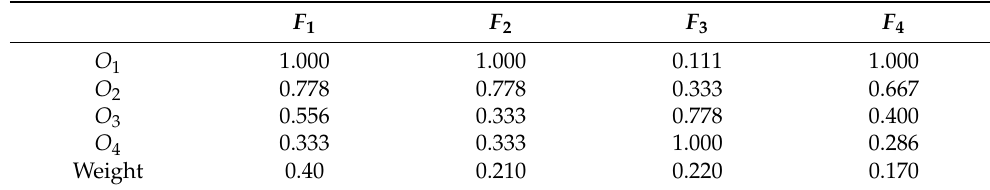
Table 2. The weights and ratings of alternative versus criteria.